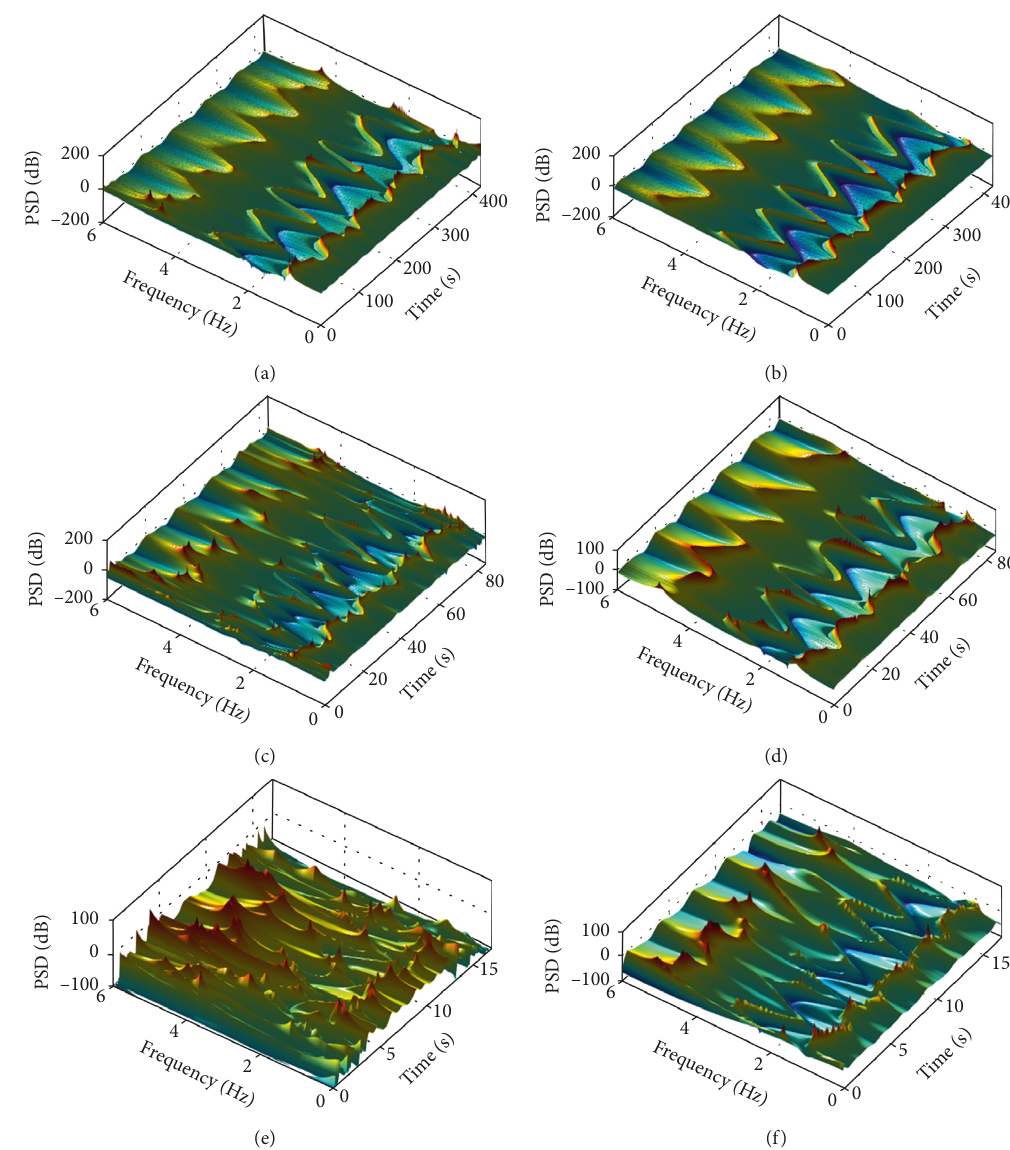
Figure 5: Power spectral density estimates by LS (a, c, e) and RR (b, d, f) for the TV numerical system with slow, medium, and fast dynamic evolution (from top to